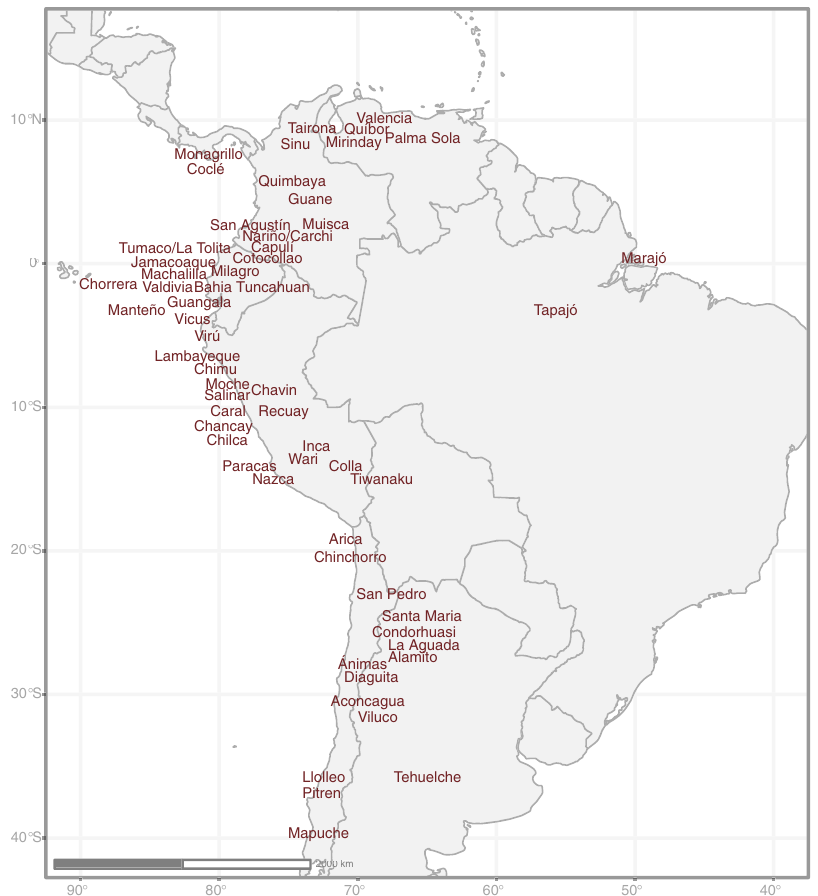
Fig. 2 Map indicating South American archaeological sites and cultures in which pre-Columbian musical instruments or sound devices have been found. Modi fi ed and expanded from Hickmann